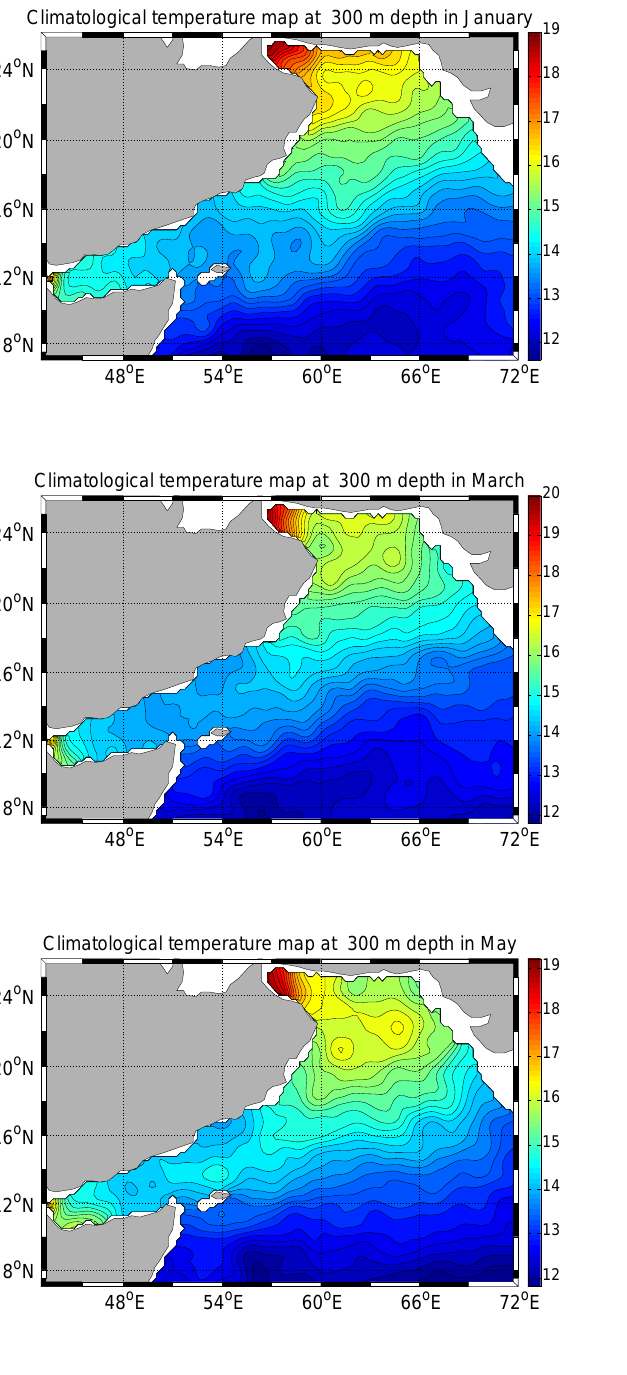
Fig. A1. (Continued from previous page) Horizontal maps of temperature (in ◦ C, left) and salinity (right) at 300m depth for January, March, May, July, September, November (from top to bottom), from the